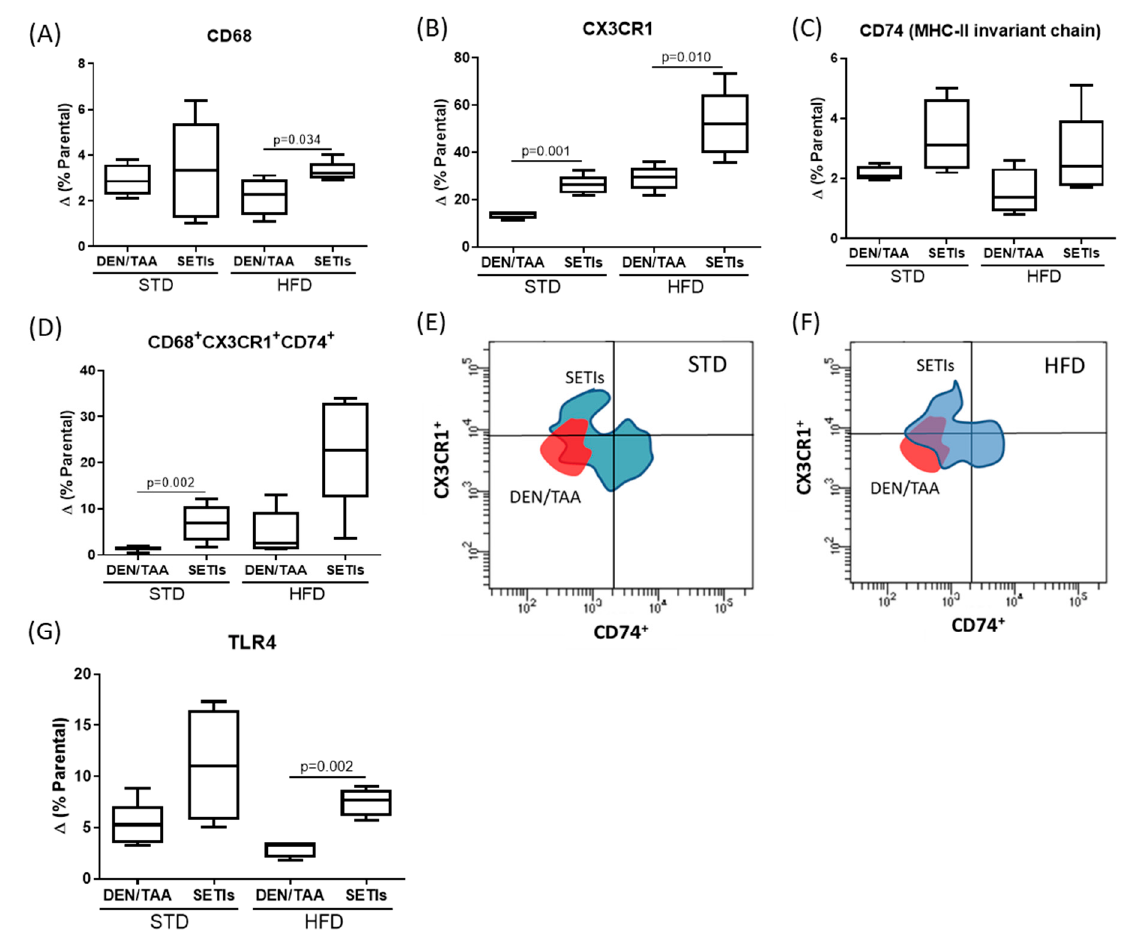
Figure 5. Immunophenotyping of the infiltrated macrophage population in DEN/TAA-treated mouse livers at 7 weeks, receiving or not receiving SETIs. Flow cytometric analysis of intrahepatic ( A ) CD68 + cells, ( B ) CD68 + CX3CR1 + cells, ( C ) CD68 + CD74 + cells, and ( D ) CD68 + CX3CR1 + CD74 + cells. Initially, the gating strategy was used to search the CD68 + population for double-positive CD68 + TLR4 + cells. This region was further plotted to identify the double-positive cells for CX3CR1 + and CD74 + : ( E ) overlaid density plots of the changes of the CX3CR1 + CD74 + population in mice fed a high-fat diet (HFD) that received or did not receive serine-type protease inhibitors (SETIs); ( F ) overlaid density plots of the changes in the CX3CR1 + CD74 + population in mice fed a standard diet (STD) that received or did not receive serine-type protease inhibitors (SETIs); and ( G ) CD68 + CX3CR1 + CD74 + TLR4 + cells. Results are expressed as mean ± mean standard error (SEM) ( n = 4 for panel ( G ); n = 6 for panels ( A – F )).